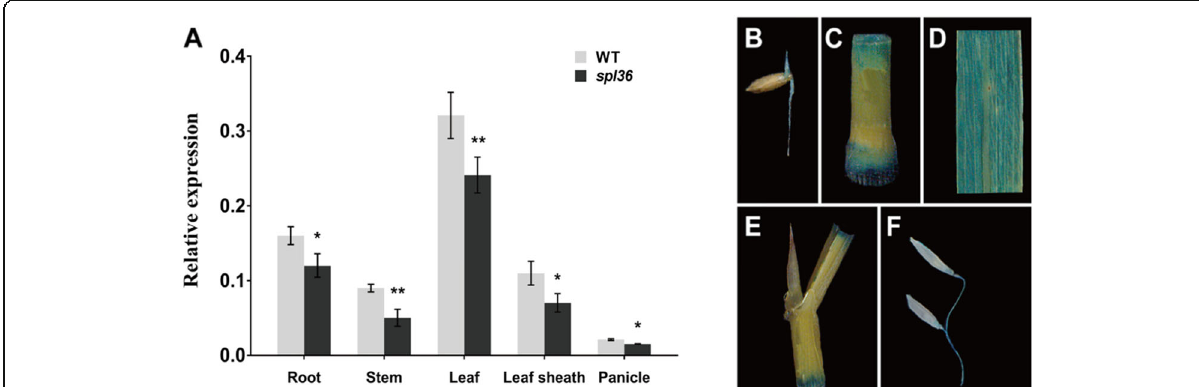
Fig. 7 Expression analysis of SPL36. a Expression of SPL36 in various organs of wild type and spl36 plants analyzed by quantitative RT-PCR. b-f Histochemical signals from the SPL36 promoter-GUS reporter gene. GUS signals were detected in the root b , stem c , leaf d , leaf sheath e , and panicle f